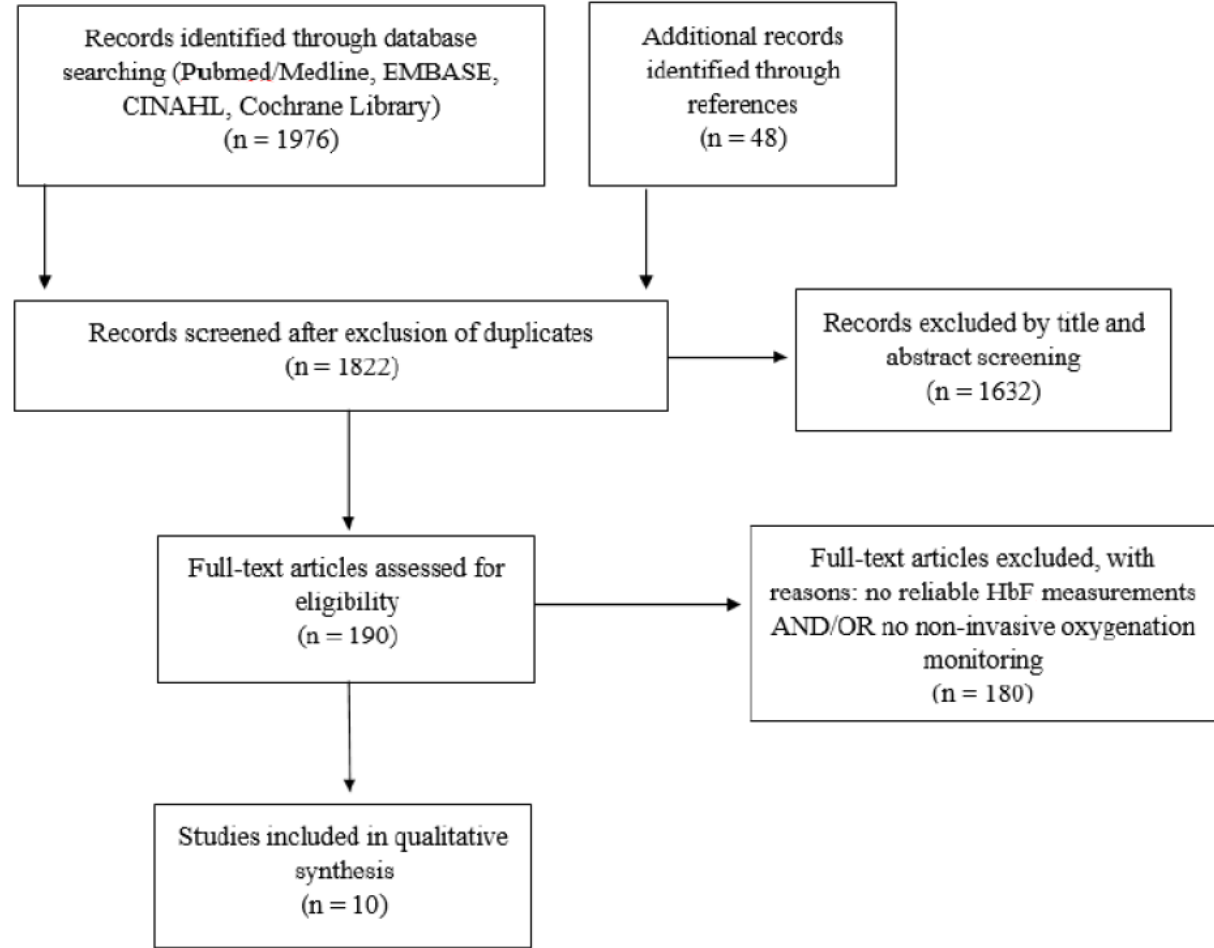
Figure 2. Study selection flow diagram.